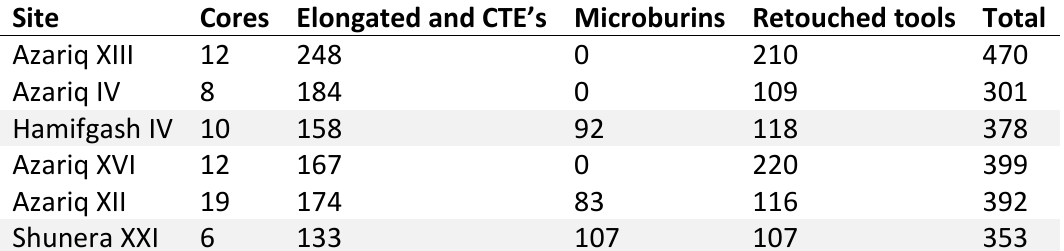
Table 3. Studied samples. Abbreviations: CTE - core trimming